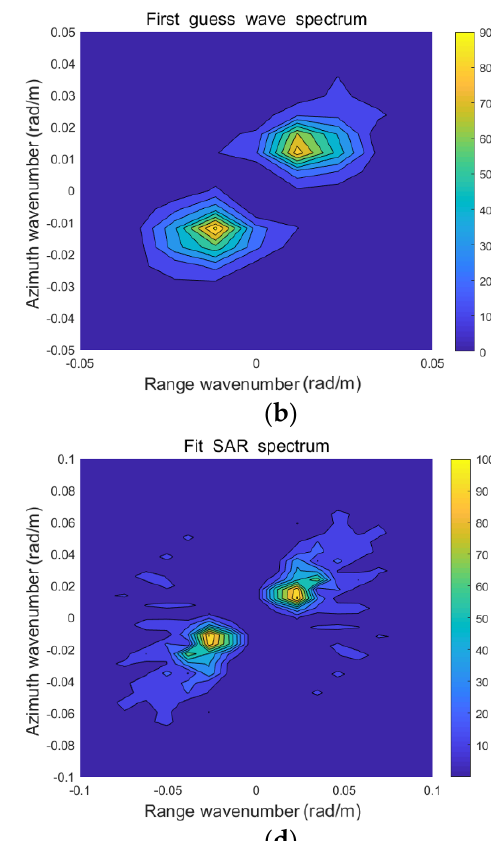
Figure 5. Wave spectrum inversion results in 256 × 256 pixels: ( a ) Observation of SAR spectrum; ( b ) First-guess spectrum; ( c ) Fit wave spectrum; ( d ) Fit SAR spectrum. Wave parameters can be calculated from the first-order moment, second-order mo- ment, and higher-order moments of the wave frequency spectrum